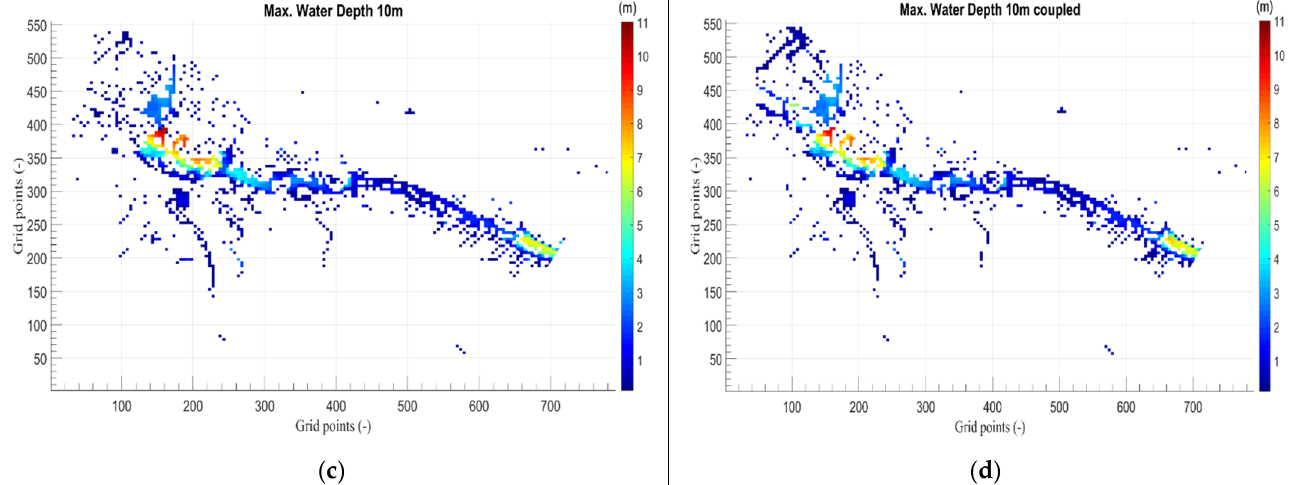
Figure 10. ( a ) Inundation in the 5 m model before the coupling process; ( b ) inundation in the 5 m model after the coupling process; ( c ) inundation in the 10 m model before the coupling process; ( d ) inundation in the 10 m model after the coupling process.